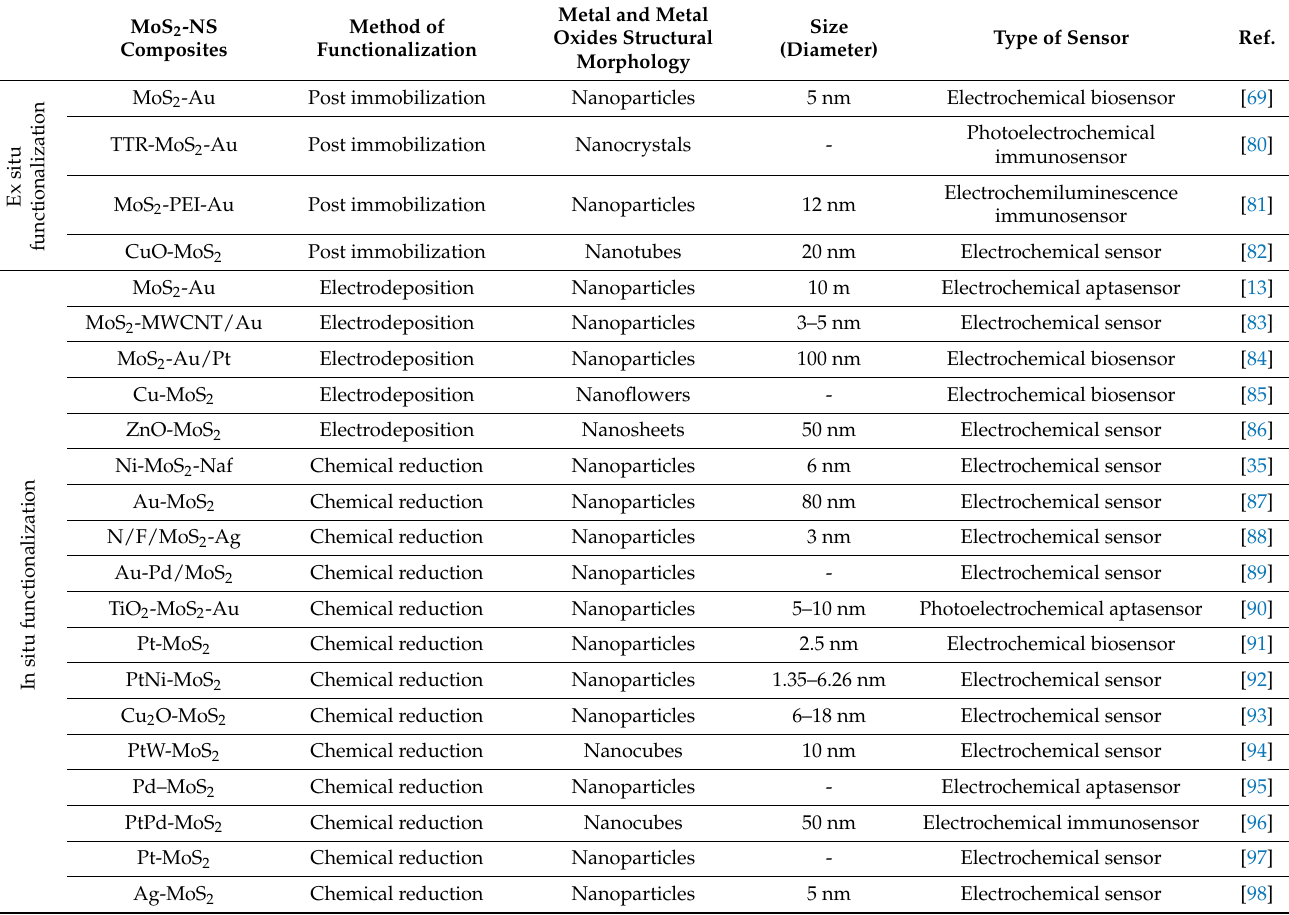
Table 1. Functionalization methods of MoS 2 nanosheets with different metal and metal oxide NSs and their applications in electrochemical